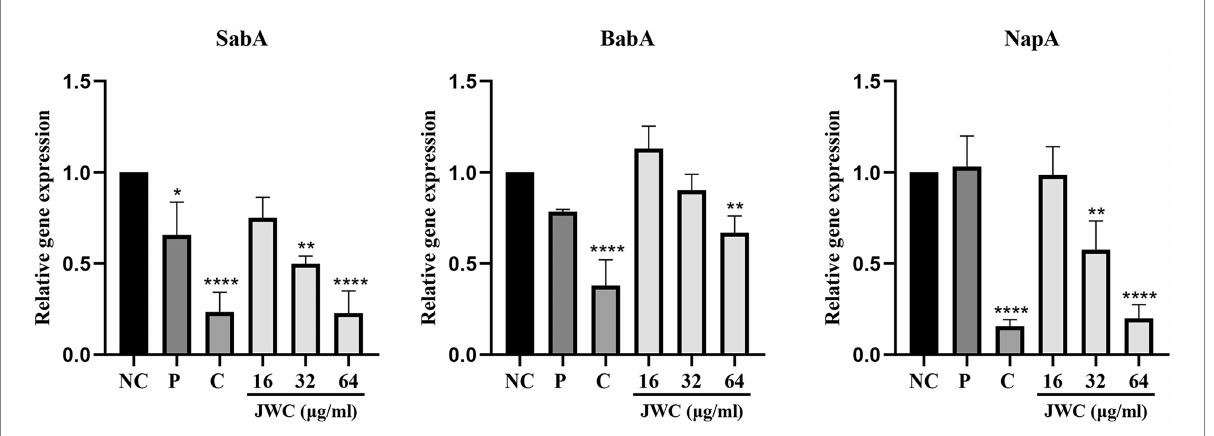
FIGURE 8 Effect of JWC on adhesions of H. pylori 26,695–16R. NC, Normal control group, H. pylori 26,695–16R; P, Pa β N (20 μ g/ml); C, CCCP (1 μ g/ml). * p < 0.05, ** p < 0.01, **** p < 0.0001, compared with the results of the control